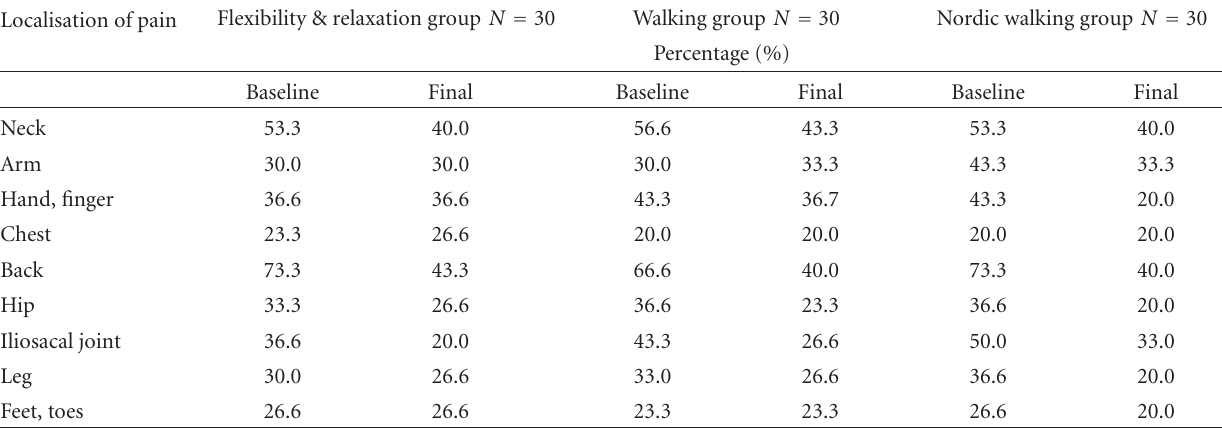
Table 3: Localisation of pain:comparison between baseline and final